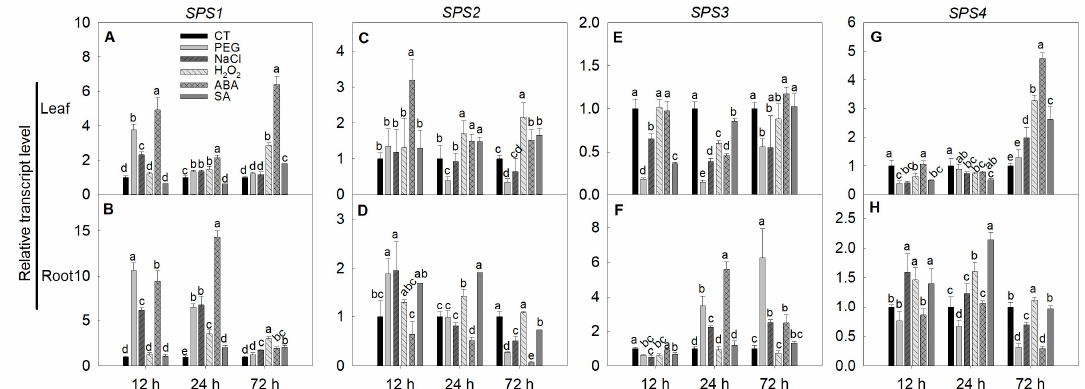
Figure 8. Changes in the expression of SPS family genes under different exogenous stimuli conditions. The three-leaf age seedlings were treated with 20% ( w / w ) polyethylene glycerol-6000 (PEG-6000), 150 mM NaCl, 1.5 mM H 2 O 2 , 50 µ M abscisic acid (ABA) or 200 µ M salicylic acid (SA) for 12 to 72 h, after which the leaves and roots were collected for gene expression analysis using quantitative RT-PCR. ( A ) SPS1 expression in leaves; ( B ) SPS1 expression in roots; ( C ) SPS2 expression in leaves; ( D ) SPS2 expression in roots; ( E ) SPS3 expression in leaves; ( F ) SPS3 expression in roots; ( G ) SPS4 expression in leaves; ( H ) SPS4 expression in roots. Actin, TIP41 and 17sRNA were used as internal controls. Data are means ± SD ( n = 3). Different letters above bars indicate a significant difference at p < 0.05. CT,